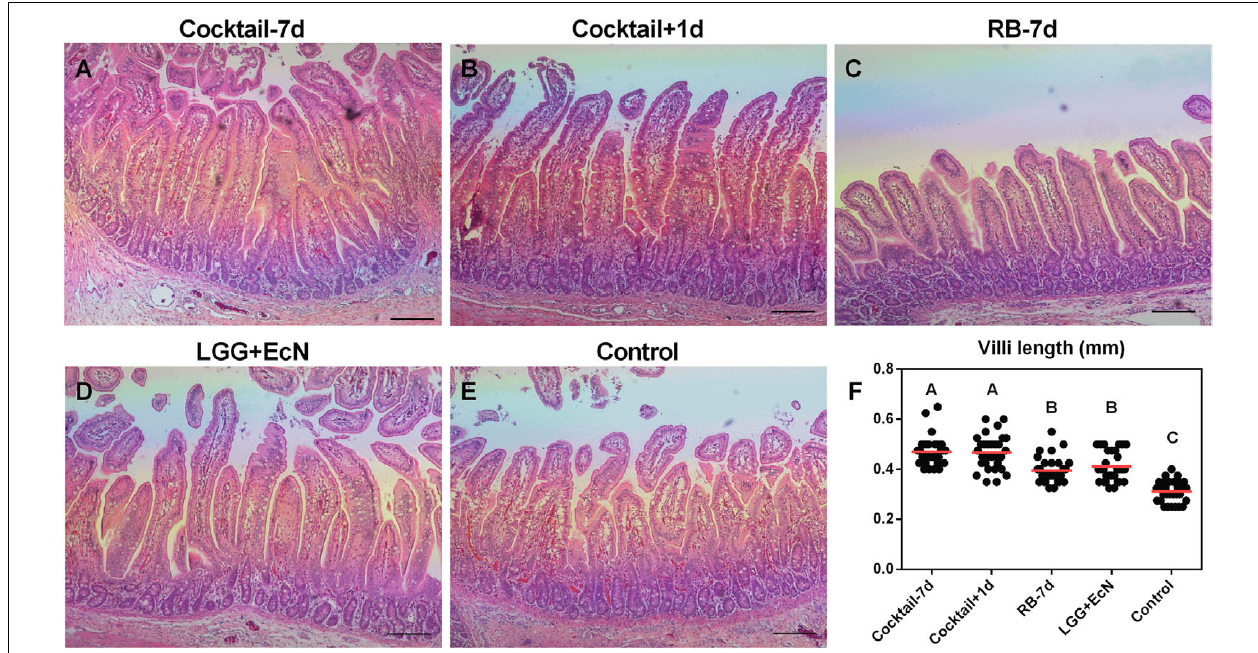
FIGURE 6 | LGG + EcN and RB are associated with longer villi. (A–E) Representative images of H&E stained jejunum showing the villi length in the five groups. Scale bar, 0.25 mm. (F) 30 random villi including all pigs in each group were measured to quantify the villi length. Data are presented as means with individual points. Statistics were determined by Kruskal–Wallis test. Different letters indicate significant differences among groups ( P < 0.05), while shared letters indicate no significant